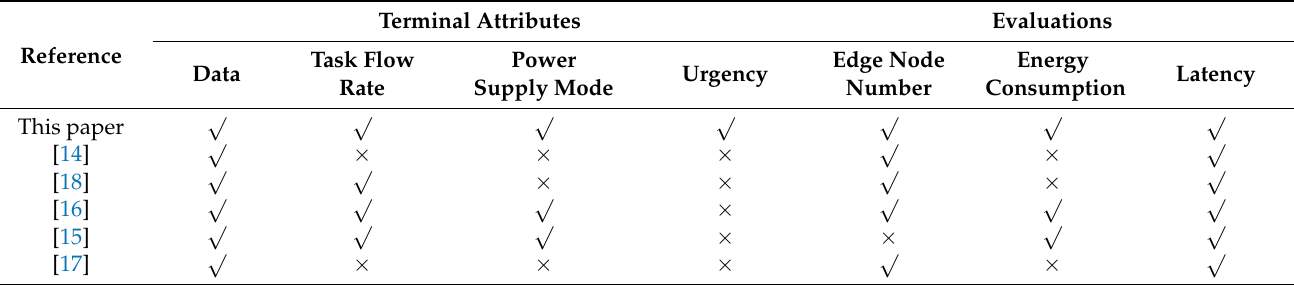
Table 1. Factor comparisons based on a literature review.